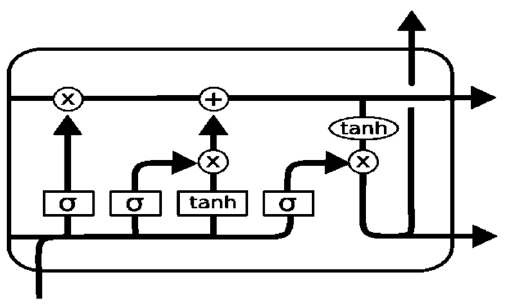
Figure 4. LSTM Figure 4. LSTM architecture.